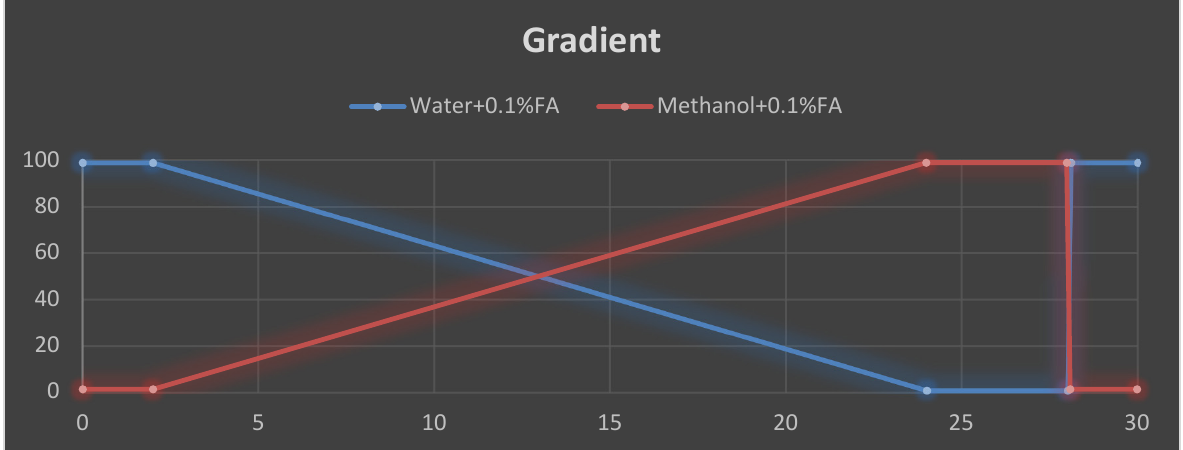
Figure 6. Gradient elution profile used for the LC-MS separation, decreasing order of mobile phase (water and 0.1% formic acid), increasing order of mobile phase (methanol and 0.1% formic acid). Data Processing: Compound discoverer 3.1 was used to treat and process the data using mzCloud Mass Spectral Library and local compound databases (exact mass or for- mula).